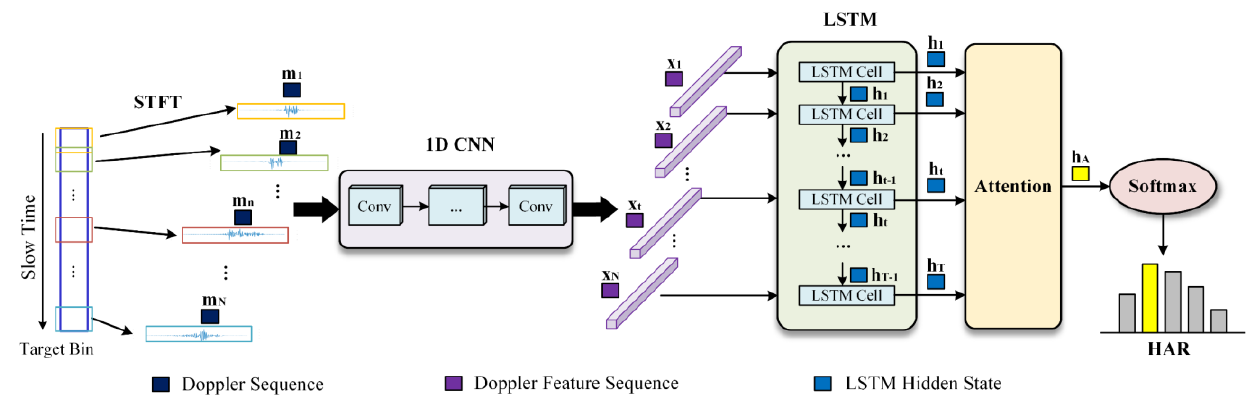
Figure 7. Proposed CLA network.